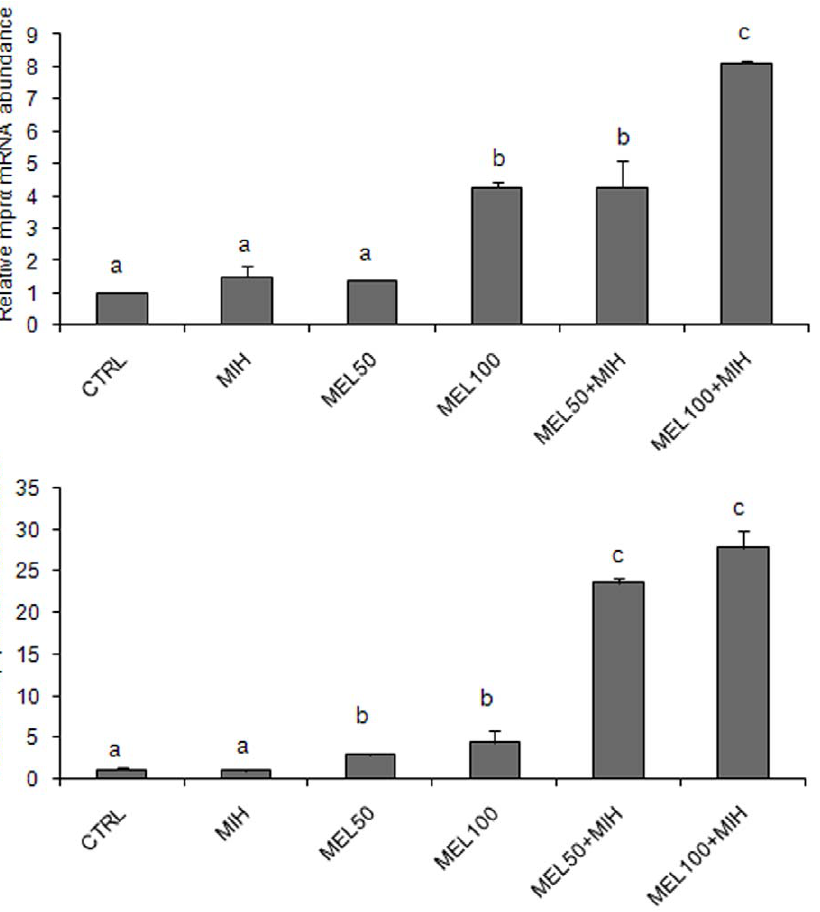
Figure 7. mpr a and mpr b m RNA levels in class IIIB follicle. (A) mpr a and (B) mpr b m RNA levels, normalized against b -actin gene in class IIIB follicle after exposure to 50 and 100 pg/ml of MEL, alone or in combination with the MIH. The different letters indicate statistically significant differences (P , 0.05), analyzed using ANOVA followed by Bonferroni’s multiple comparison test.